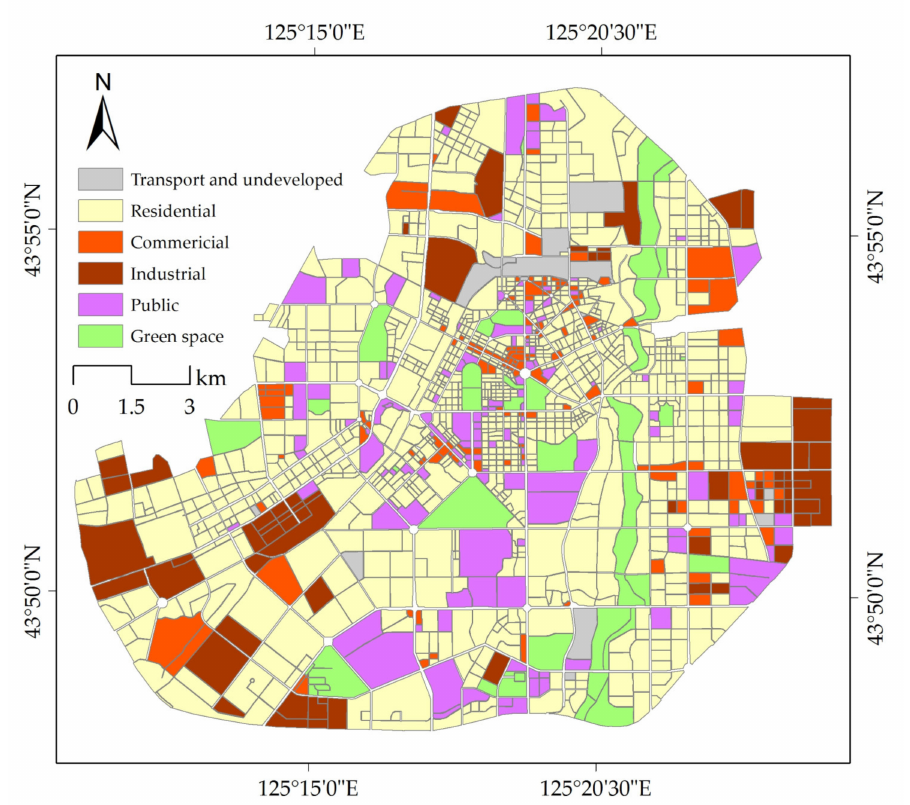
Figure 9. Essential urban land use map in the downtown area of